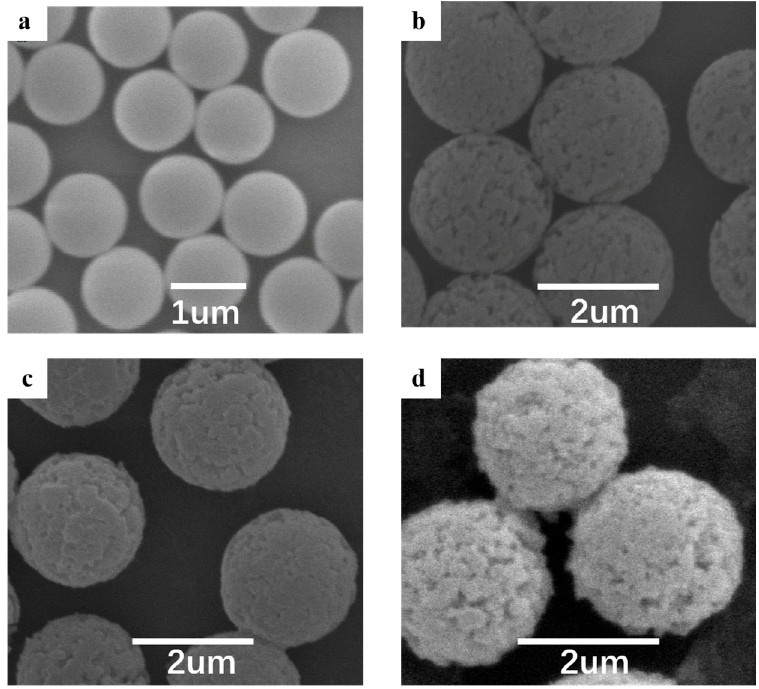
Figure 3. SEM (scanning electron microscopy) images of PMMA seed spheres ( a ); porous PMMA microspheres ( b ); porous magnetic PMMA microspheres ( c ); and DR-encapsulated magnetic PMMA microspheres ( d ).